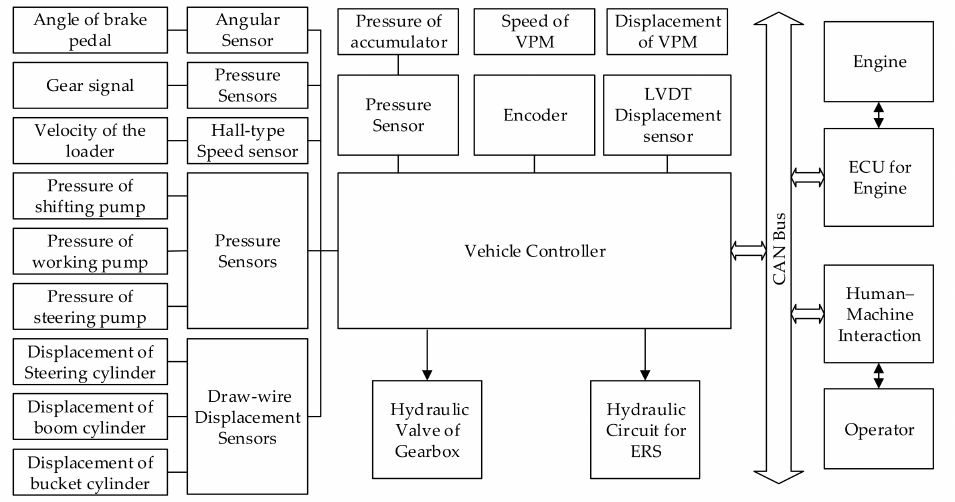
Figure 23. The block diagram of the experimental setup.